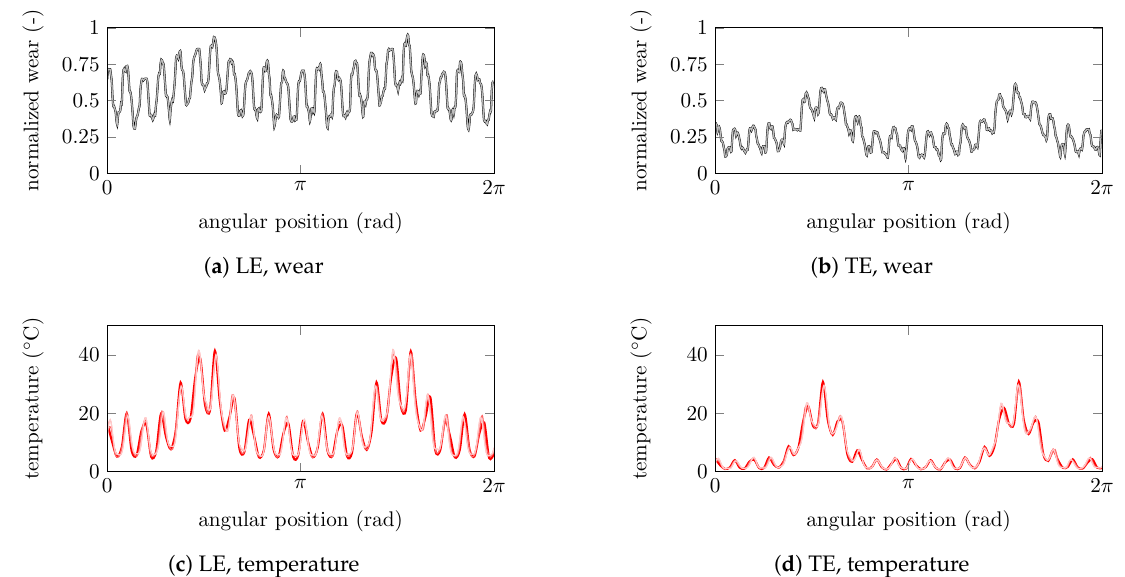
Figure 5. Convergence analysis of the wear and temperature profiles at the end of the simulation at the leading and trailing edge with the number of thermal abradable coating elements n ab , th : n ab , th = 80 or R s = 250 (